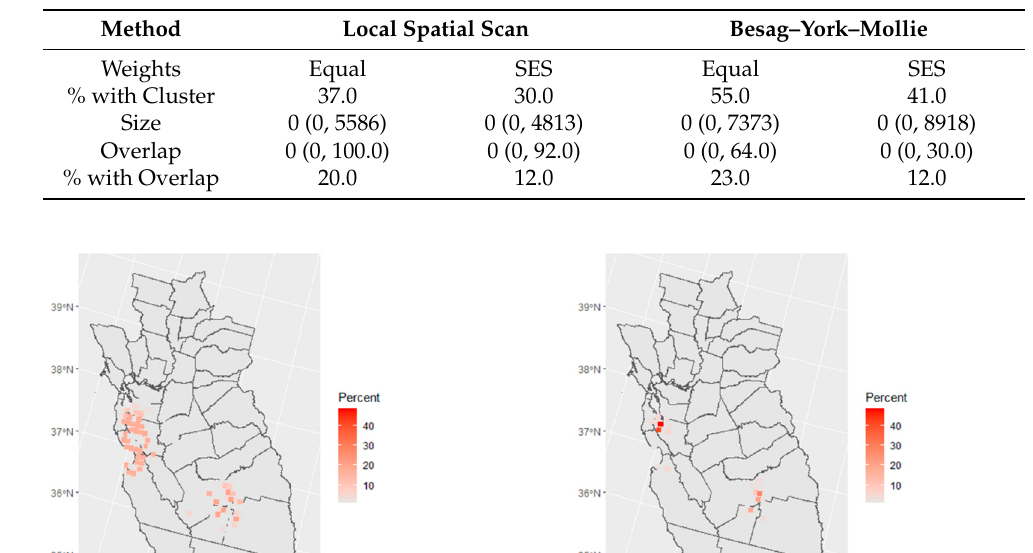
Figure 6. Significant spatial cluster in red detected using local spatial scan ( left ) and BYM model ( right ) based on the observed data. Table 3. Summary of spatial cluster detection results in simulations adding participants to the observed sample to evaluate selection bias. Notes: Weights refers to the sampling weights applied to census tracts for added control participants. Equal refers to equal weight given to income deprivation, education deprivation, and population for a census tract. SES refers to 50% greater weight given to income and education deprivation than to population for a census tract. Quantities in the table for Size and Overlap refer to the median and 95% percentile-based interval in square kilometers for the convex hull of the spatial cluster.